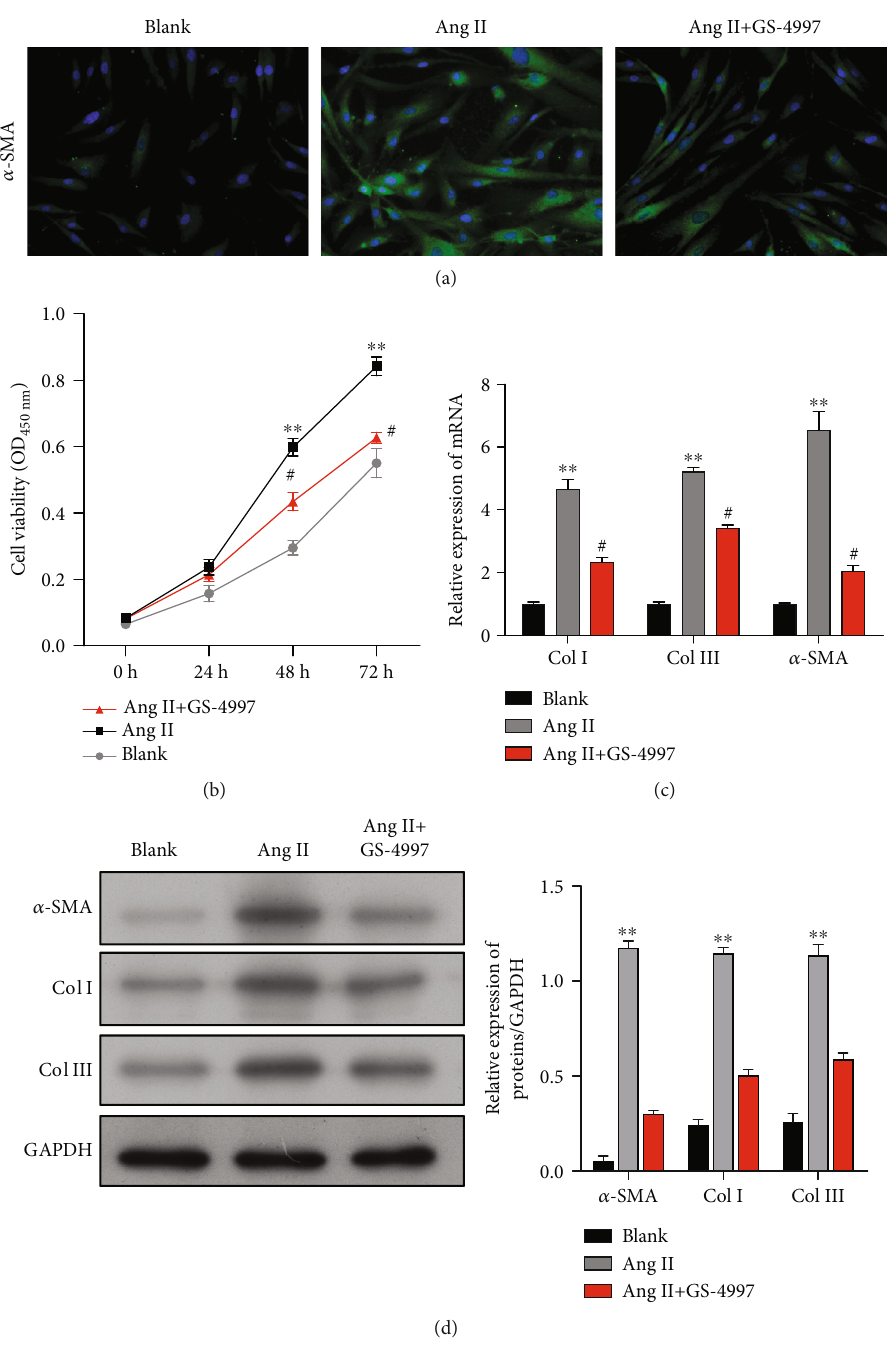
Figure 5: E ff ects of an ASK1 inhibitor on Ang II-mediated proliferation and ECM-related protein expression in LX-2 cells. LX-2 cells were treated with Ang II alone or cotreated with Ang II and an ASK1 inhibitor (GS-4997). (a) Immuno fl uorescence images of α -SMA in LX-2 cells. (b) Cell viability was determined by the CCK-8 assay. (c) Quantitative real-time PCR and (d) western blotting were performed to measure the levels of α -SMA, Col I, and Col III expression in LX-2 cells. Results are expressed as the mean value ± standard deviation (SD). ∗∗ p < 0 : 01 vs. blank; # p < 0 : 05 vs. Ang